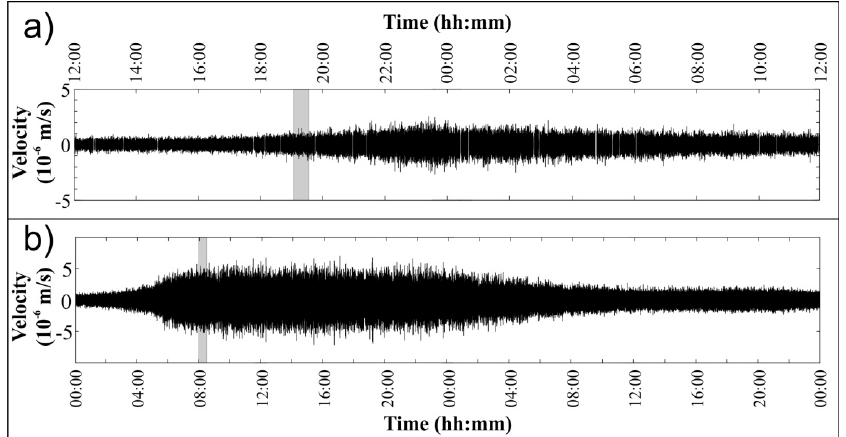
Figure 3. ( a ) Vertical component of background seismic signal (from November 4, 2002, 12:00 p.m. to November 5, 12:00 p.m.). The amplitude increase was recorded during a lava fountain episode. Due to